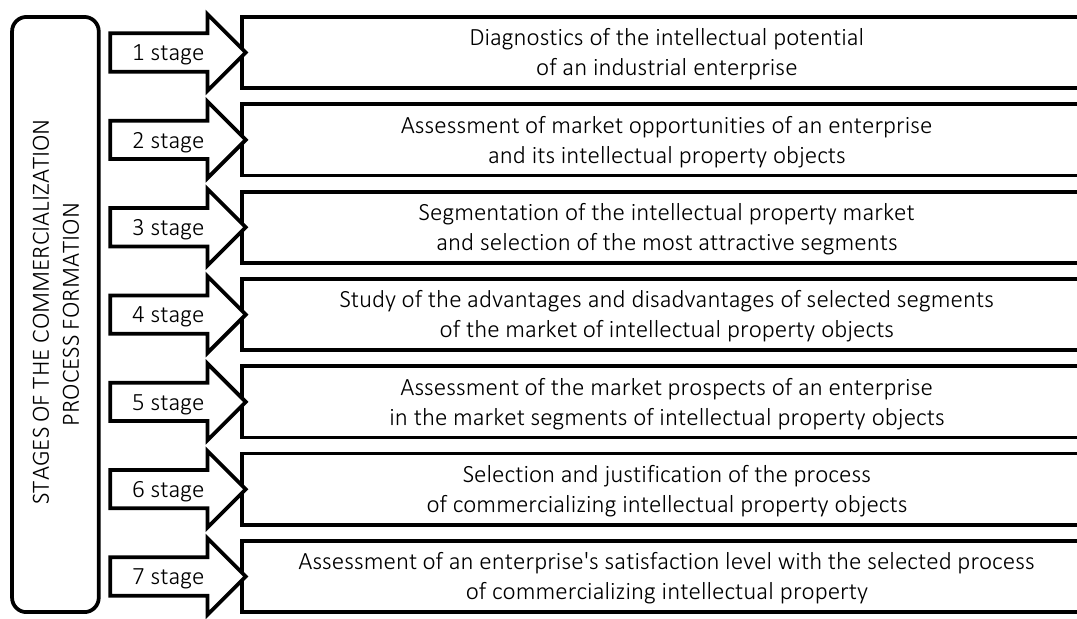
Figure 1. Stages of commercialization of intellectual property objects in an industrial enterprise